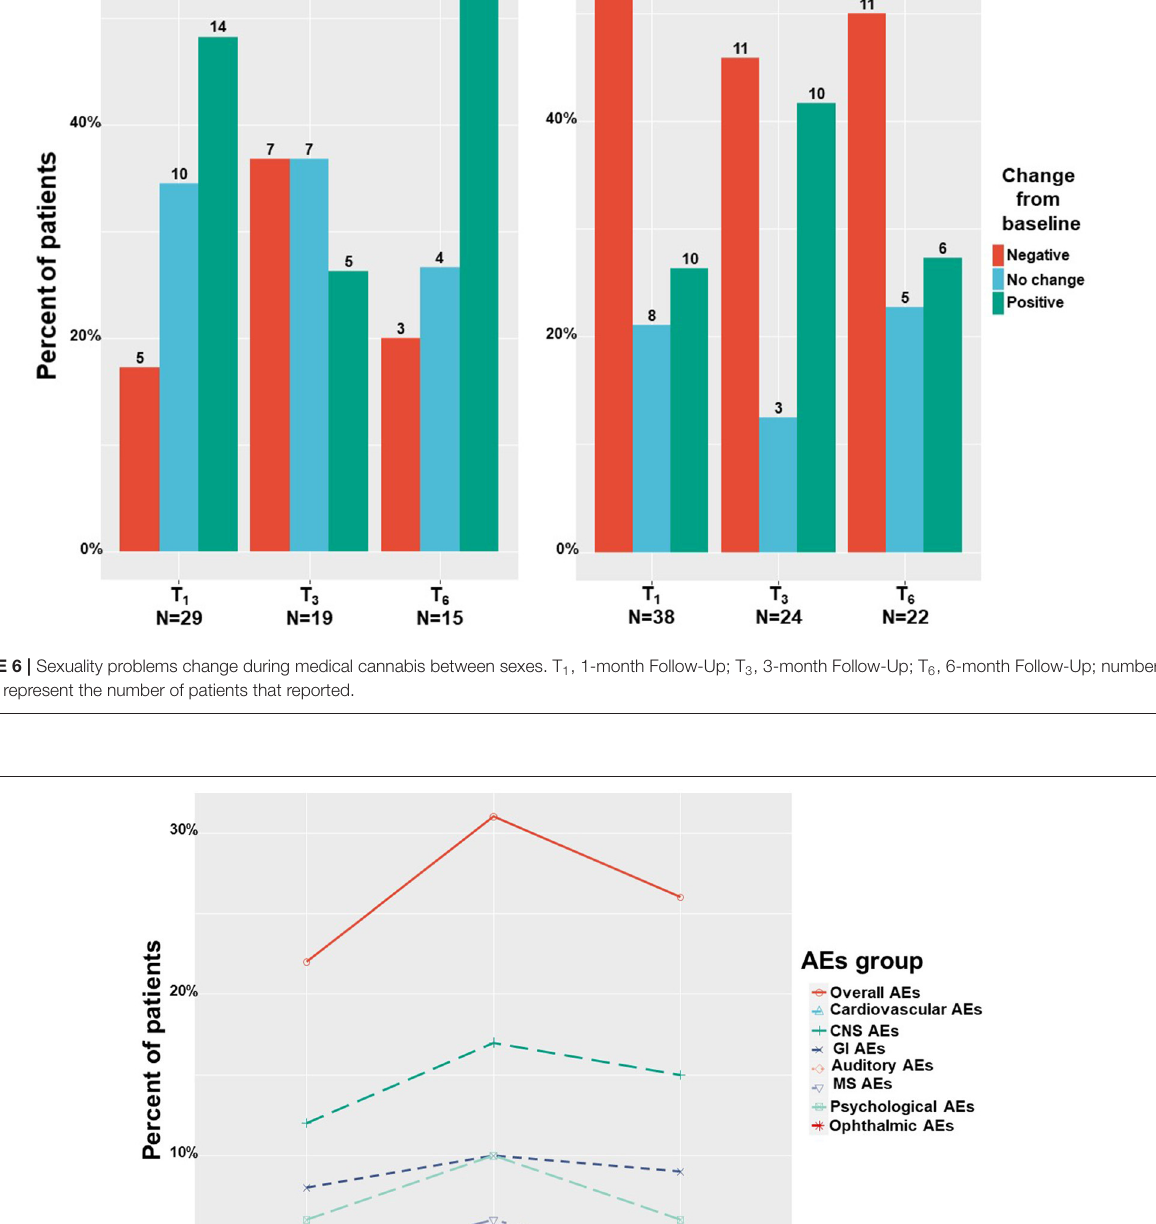
Frontiers in Pain Research |